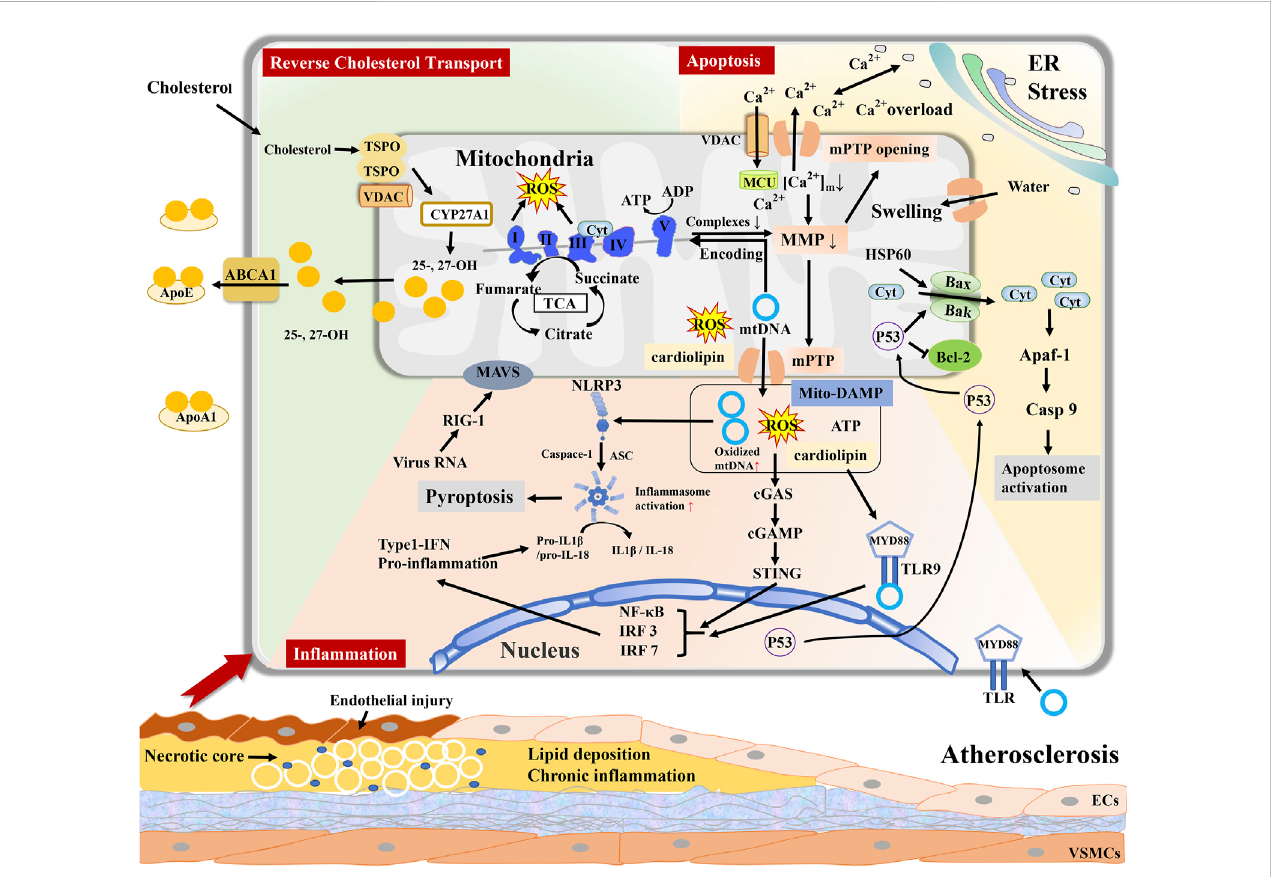
FIGURE 1 Mitochondriaregulatereversecholesterol transport (RCT),cell apoptosis, and in fl ammatoryresponse during atherosclerosis.Excessive accumulation of cholesterol entry into mitochondria generate and esterify 25- and 27-hydroxycholesterol ((25-/27-OH)) by CYP27A1. Inhibition of ABCA1 results in RCT impairment and peroxidation damage in the mitochondria of macrophages. Mitochondria-DAMPs include mtDNA, mtROS, ATP, and cardiolipin, and export via mPTP. Mito-DAMPs are recognized as a pathogen to elicit in fl ammation, such as TLR9 signaling, cGAS – cGAMP – STING pathway, and inducing NLRP3 in fl ammasome to stimulate in fl ammatory cascade response. mPTP opening causes Ca 2+ and cytochrome C (Cyt) ef fl ux and mitochondrial swelling, leading to cellular apoptosis. Mitochondrial dysfunction contributes to lipid deposition, in fl ammation, and cellular apoptosis in the vascular wall, jointly promoting atherosclerosis